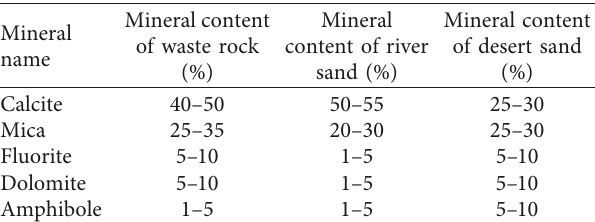
Table 2: Analysis results of mineral